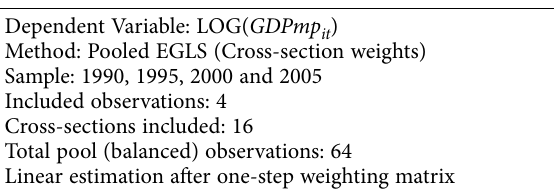
Table 9. Estimation equation for gross domestic product at market prices across autonomous